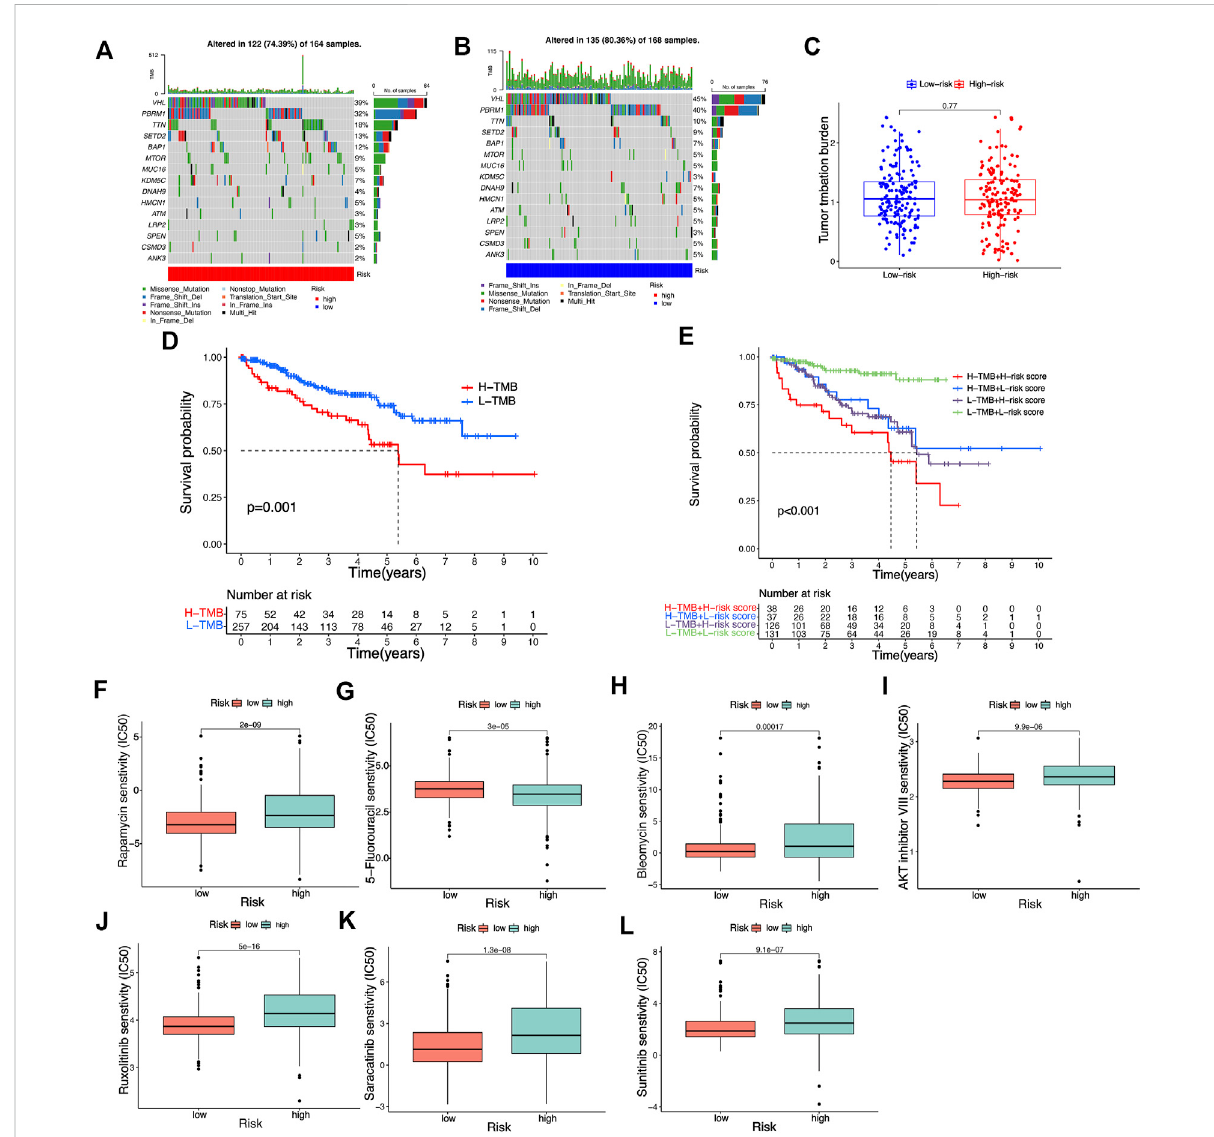
FIGURE 10 Analysis of tumor mutation burden and prediction of potential drug susceptibility in different risk groups. (A,B) The waterfall plot illustrates the type and frequency of tumor mutational burden in high-risk and low-risk KIRC patients. (C) Differences in tumor mutation burden scores among different risk groups. (D,E) K-M survival curves of KIRC patients with different risk scores and tumor mutation burden scores. (F – L) Differences in IC50 values of common drugs in different risk